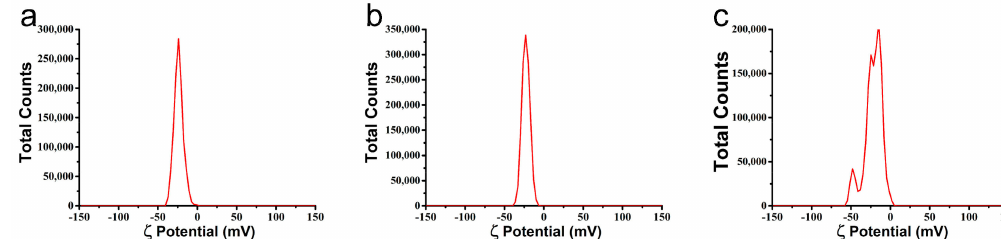
Figure 4. Zeta potentials of the azoxystrobin microspheres. ( a ) MS1; ( b ) MS2; ( c ) MS3.